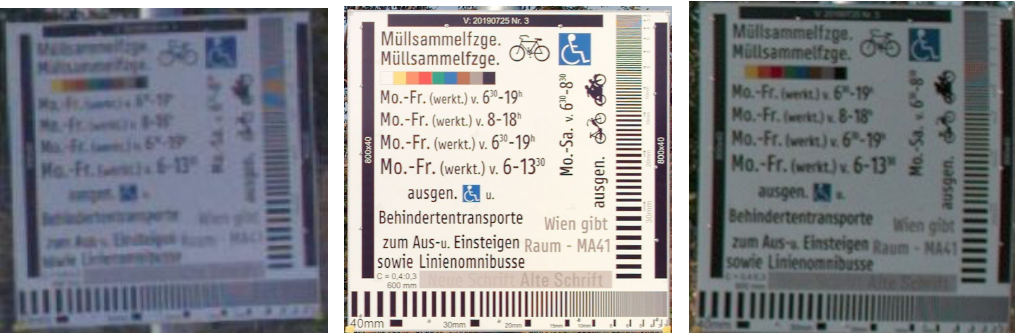
Figure 4. Three test charts as seen by the panorama images of three mobile mapping systems. From top to bottom: System A, B, C, from left to right: forward, orthogonal, backward view at the test charts in the distance of 10m.